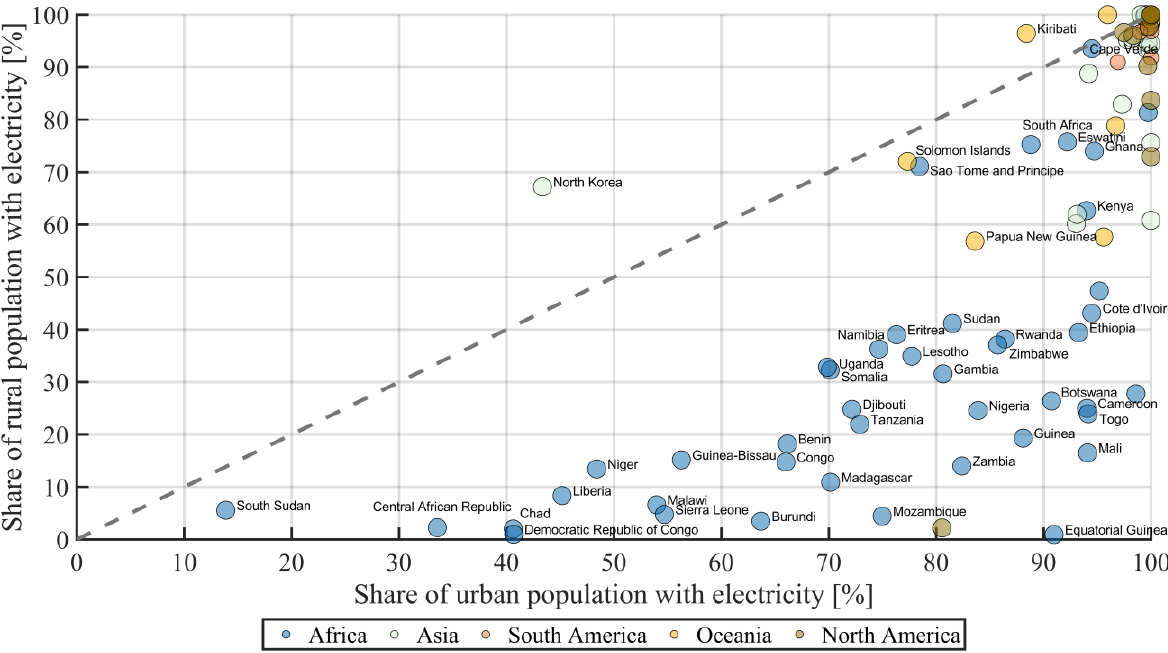
Figure 1. Share of rural and urban population with access to electricity (2020). Own work based on data from: [6,7].